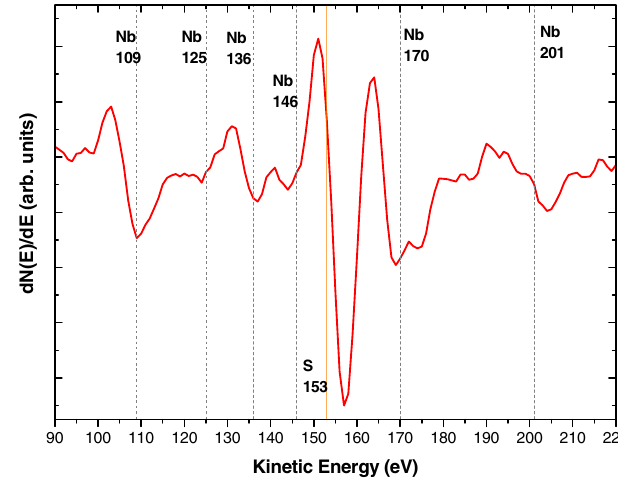
FIG. 6. EDX spectrum surveyed at a spot of the granule (as shown in Fig. 5, survey area 300 (cid:3) 200 nm 2 ). Only oxygen and niobium elements are observed. The fingerprint positions of Nb, O, S, and C are all labeled by gray lines for reading convenience.